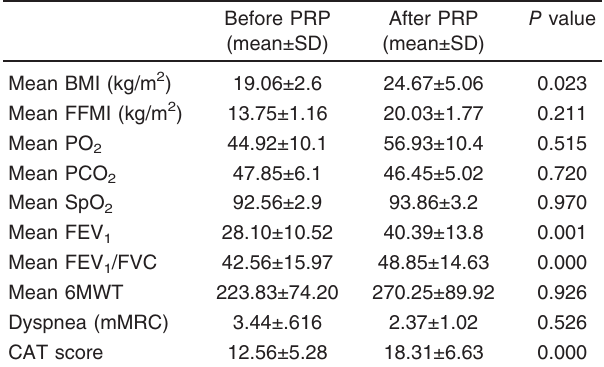
Table 4 Statistical Comparison between different variables in the muscle depleted group with cachexia before and after pulmonary rehabilitation program Before PRP (mean±SD)